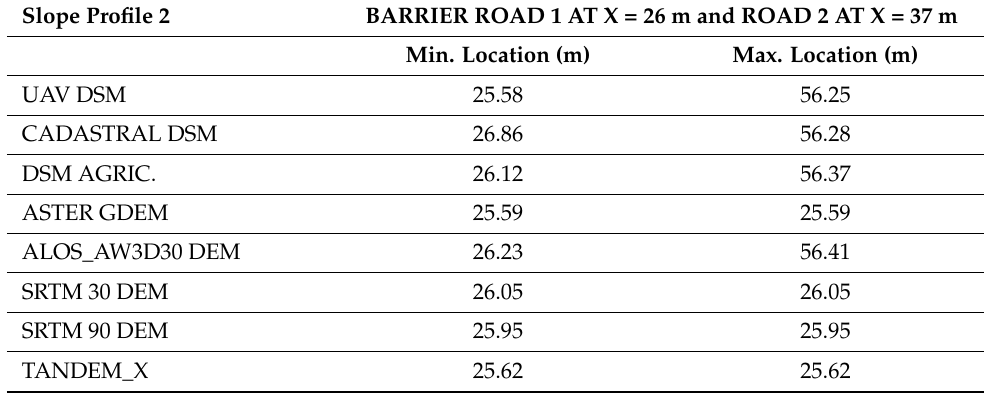
Table 8. Horizontal location of rock end points for the 2nd slope